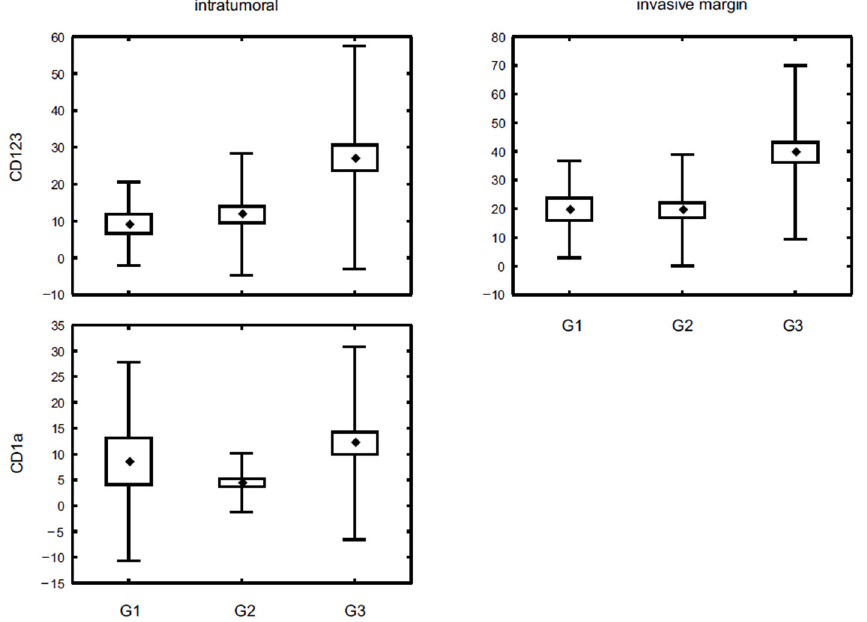
Figure 2. The density of CD123+ and CD1a+ DC populations in breast cancer specimens represent- ing different nuclear grade. Central point is the arithmetic mean, box is the arithmetic mean ± standard error and whisker is the arithmetic mean ± standard deviation.